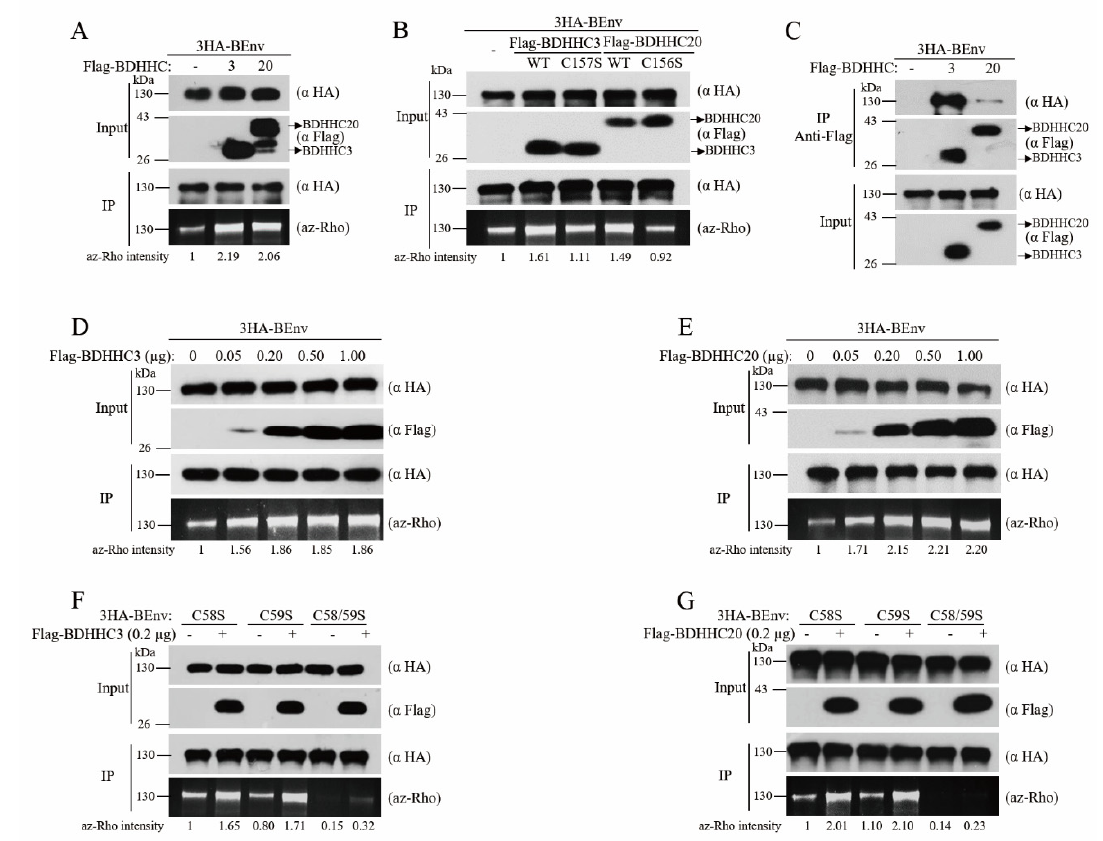
Figure 2. BDHHC3 and BDHHC20 interact with BEnv and palmitoylate BEnv at C58 and C59. ( A , B ) HEK293T cells were co-transfected with BEnv and either wild type BDHHC3, BDHHC20, or their mutants (BDHHC3-C157S and BDHHC20-C156S). Levels of BEnv palmitoylation were evaluated as described in Figure 1. The az-Rho intensities were quantified with Image J. ( C ) HEK293T cells were co-transfected with 3HA-BEnv and either Flag-BDHHC3, Flag-BDHHC20, or an empty vector. Cell lysates were subjected to immunoprecipitation with the anti-Flag antibody. The co-immunoprecipitated BEnv was analyzed using the anti-HA antibody (the top panel). Ten percent input of total ex- tracts was probed with anti-HA and anti-Flag to verify expression of 3HA-BEnv, Flag-BDHHC3, Flag-BDHHC20. ( D , E ) 3HA-BEnv was co-transfected into HEK293T cells with increasing doses of expression plasmids coding for either Flag-BDHHC3 or Flag-BDHHC20. Then, the total cell lysates were prepared and subjected to the click chemistry reaction to evaluate the levels of BEnv palmitoylation. The az-Rho intensities were quantified with Image J. ( F , G ) HEK293T cells were co-transfected with BEnv palmitoylation site mutants (C58S, C59S, and C58/59S) and either BDHHC3 or BDHHC20. Levels of BEnv palmitoylation were visualized by az-Rho fluorescence gel scanning. The az-Rho intensities were quanti- fied with Image